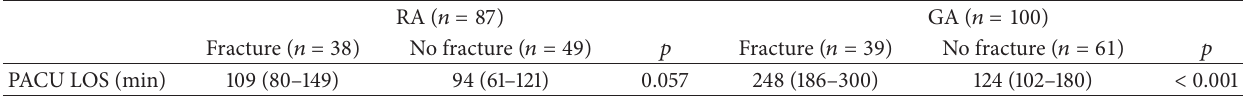
Table 4: Univariate analyses within the subgroups RA/GA concerning fracture surgery or not.